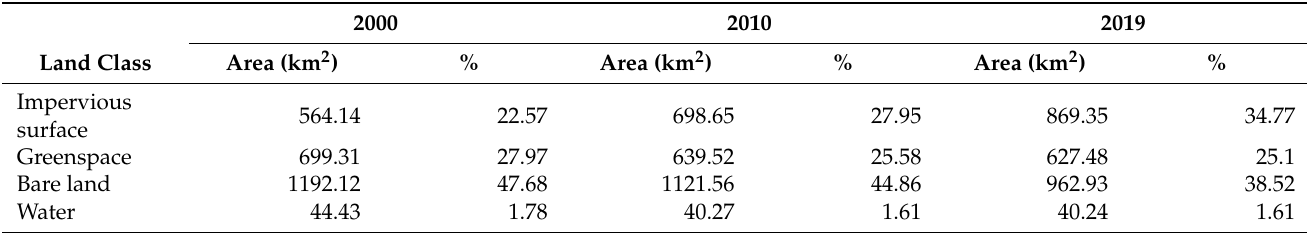
Table 2. Area change in the LUC in the study